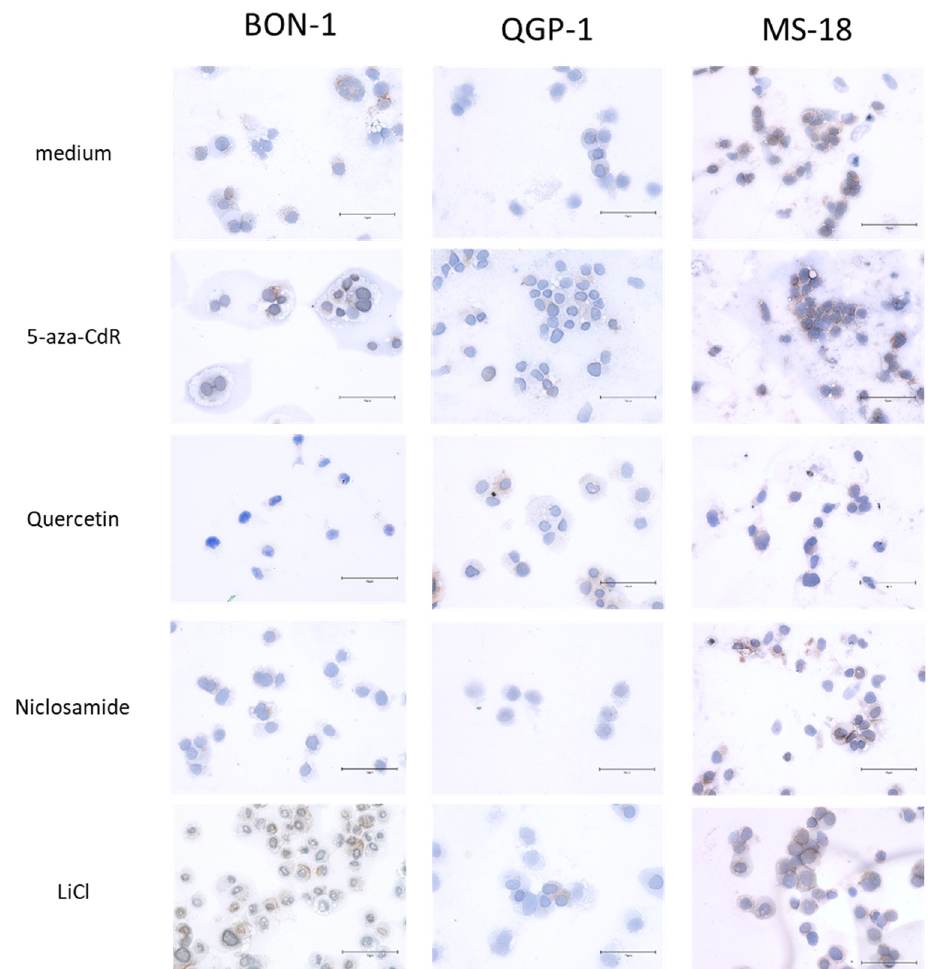
Figure 4. Immunohistochemistry staining of CXCR4 in BON-1, QGP-1, and MS-18 cells either before (control) or after incubation with Wnt modulators. The bar in the images represents 75 µm. The percentage of CXCR4-positive cells after immunohistochemical staining in BON-1, QGP-1, and MS-18 after Wnt modulator treatment is shown in Supplementary Materials Figure S2.